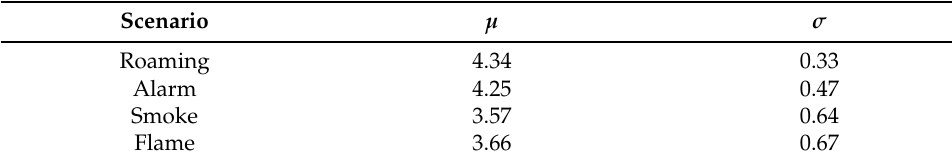
Table 12. Mean values and standard deviations of binned entropy of gaze.